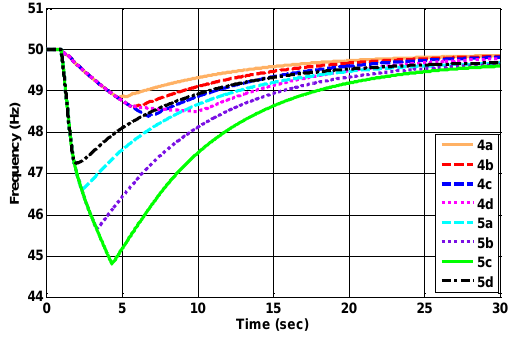
Figure 4 . Frequency profile with EDR and LS scheme outage at